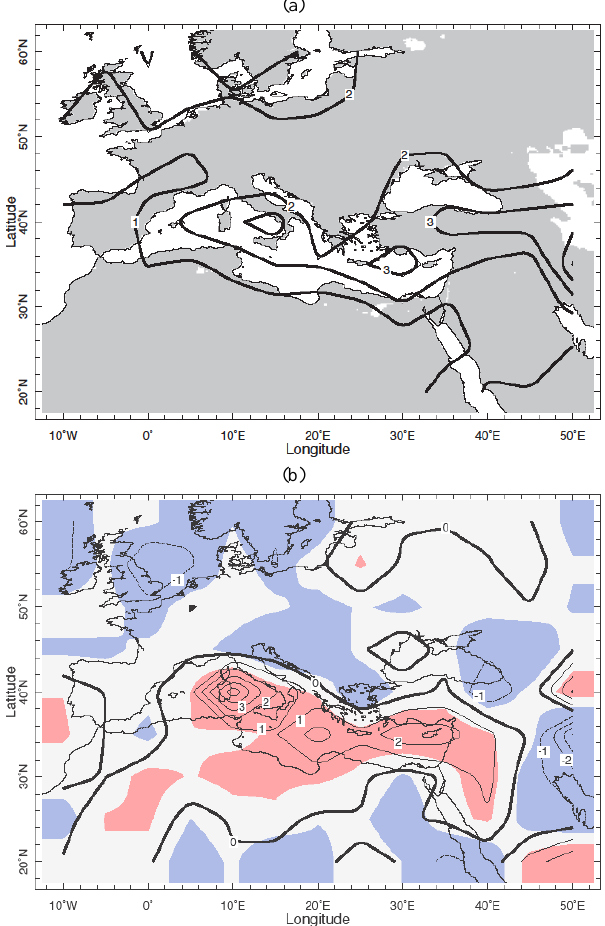
Fig. 3. (a) As for Fig. 2, but averaged over the 9 study models. The counts of each model are normalized by the ratio between its total number of detected cyclones and that detected in the observa- tions. (b) The difference between the observed and model-averaged (Figs. 2 and 3a, respectively). The contours are in 1.0 interval and the zero line is thick. The t-test is a “Welch t-test”, which accounts for the different variance in the observations and models. The mod- els are pooled together and normalized, as explained in the test. The colors indicate regions in which the difference is significant at the level of 95% based on an estimate of 40 degrees of freedom; pale pink indicates significant model under-estimation and pale blue in- dicates significant model